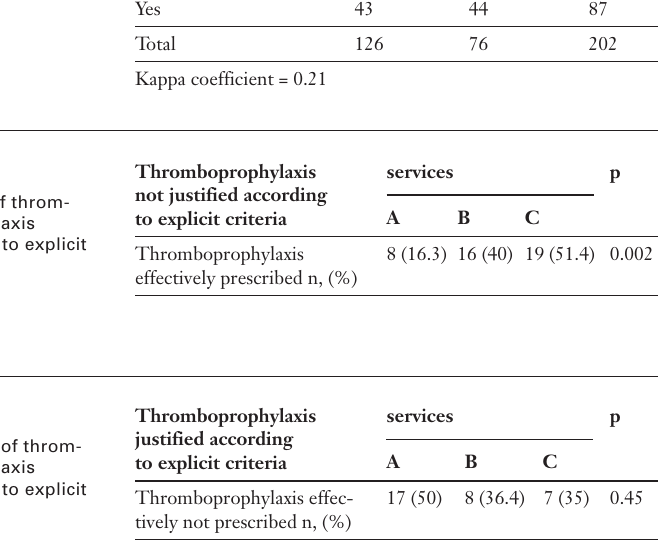
Appropriateness of thromboprophylaxis.